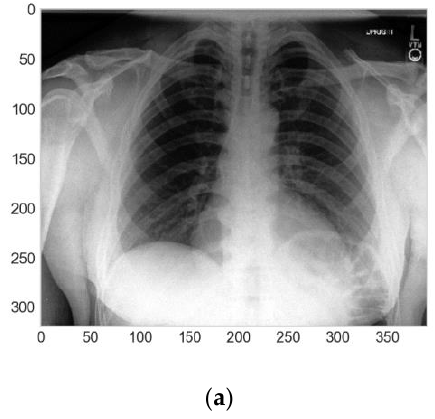
( d ) Figure 3. Comparison of the original and augmented images: ( a ) original image from CheXpert da- taset; ( b ) original image from ChestX-ray14 dataset; ( c , d ) augmented images after preprocessing. 2.6. CNN Programming, Transfer Learning, and CNN Modifications In this work, we used two CNNs. First, as the base model and feature extraction, we used the model in [17]. Besides, we applied the transfer learning technique using the weights configuration from the ImageNet dataset [33] and unfroze the weights for the last 2 convolutional blocks of [17] on our dataset. The transfer learning technique consisted in using the weights of the CNN trained for a similar propose, i.e., classification problem, preconfigured in one dataset. In this case, we used the weights achieved in the Imagenet dataset [33]. CNNs were adapted to image processing, being able to process two-dimensional (2D) or three-dimensional (3D) images. Here, we focused on 2D images. To do that, dif- ferent types of layers were used, from which we included mainly two layers — convolu- tional (Conv) and pooling (Pool) layers. A convolutional layer is the core building element of a CNN, in which the features are detected, filtered and identified. A pooling layer (or downsampling layer) is used for dimensionality reduction, reducing the number of pa- rameters in the input. A pooling minimization layer can also be used. The algorithm starts by processing the inputs with the first core convolutional layer, a succession of convolu- tional layers, and eventually pooling or min pooling layers plus a final synthesis layer. With each layer, the CNN increases the complexity to identify greater portions of the im- age. Earlier layers focus on simple features, such as colors and edges. As the image data progress through the various layers of the CNN algorithm, it is able to recognize larger elements or shapes of the X-ray image until it finally identifies the intended object and